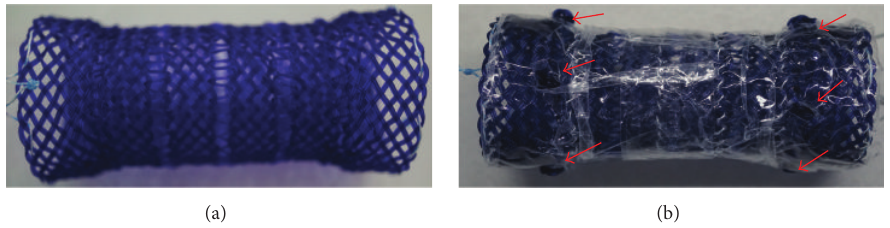
Figure 1: Two segmented polydioxanone made biodegradable esophageal stents. (a) An uncovered stent. The stent was with a segmented 28 × 80mm trunk and two 30 × 10mm cup ends. The trunk was composed of four independent segments, connected with 4 mm long polydioxanone monofilament. Each segment was woven by double polydioxanone filaments and was 10mm in length. (b) A fully covered biodegradable stent. A layer of poly-L-lactic acid membrane, 0.5 mm in thickness, was covered to an uncovered stent. Four protrusions, 3 mm in diameter, were attached to each cup end (red